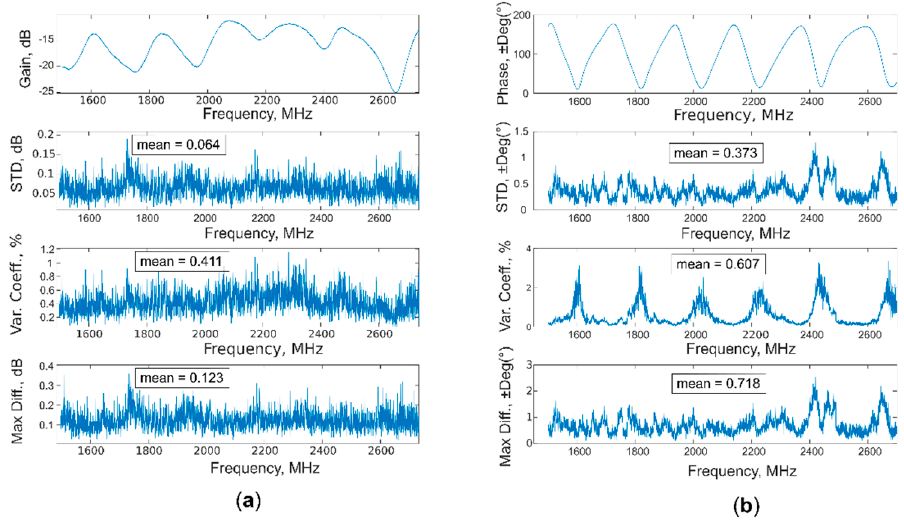
Figure 12. Standard deviation, coefficient of variation, and maximum difference calculated both for ( a ) gain and ( b ) phase, from a total of nine acquisitions on air.